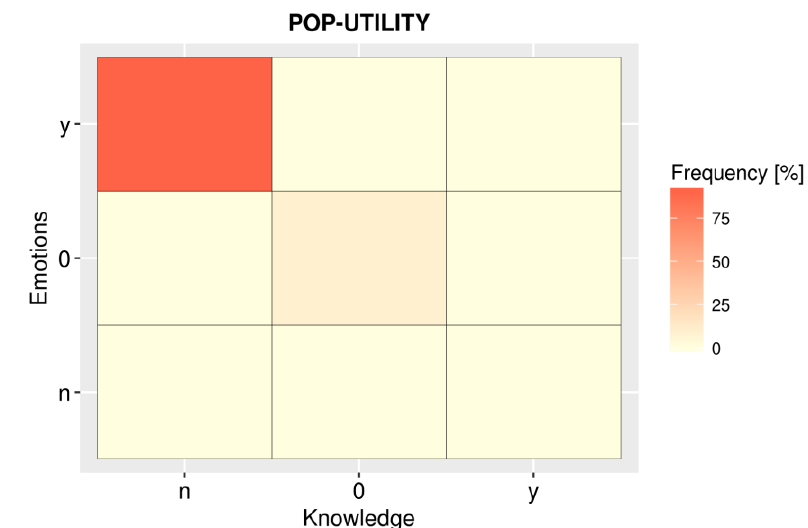
Figure 6. Frequency of responses compared between the knowledge and emotions dimensions—pop-utility theme.